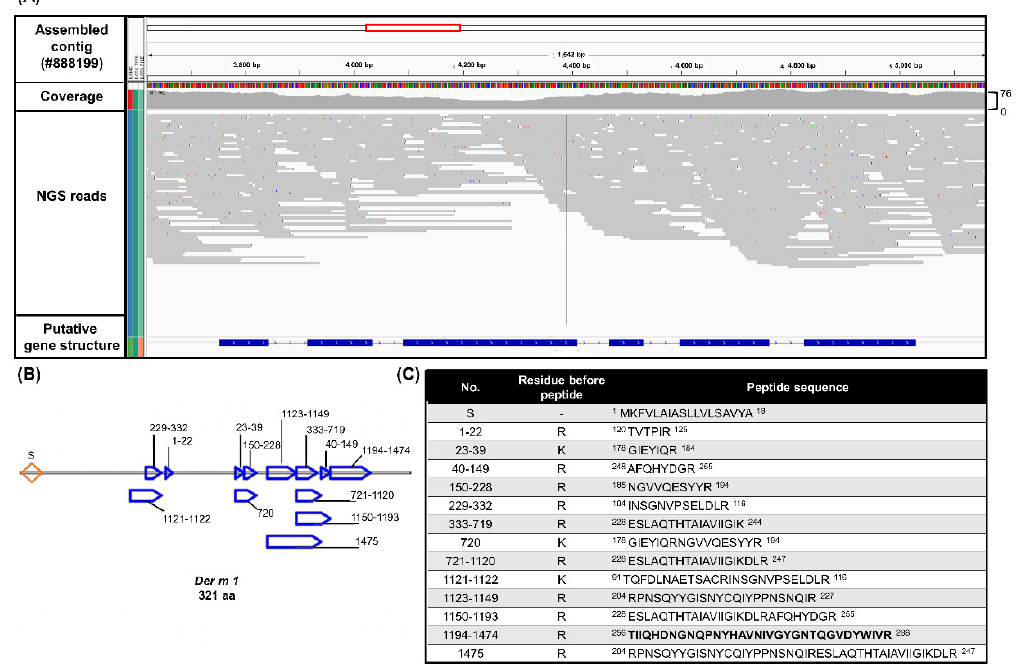
Figure 1. The annotated sequence of the major allergen Der m 1 . ( A ) The predicted DNA sequence of putative Der m 1 was shown by Interactive Genomics Viewer (IGV) with the aligned NGS reads as gray lines. The first and second rows show the assembled contig sequence (config #888199; 13,888 bp) and the NGS reads coverage, respectively. The third row shows the sorted NGS reads mapped to the corresponding region mismatching the assembled Der m genomic reference indicated by color with alpha transparency proportional to quality. The fourth row shows the predicted exon–intron structure of Der m 1 using the sim4 package. ( B ) The LC-MS/MS proteomic data showed the specific fragment of the deduced 231-amino-acid sequence of Der m 1 . The peptide fragments were mapped to the Der m 1 proteins and the unique peptide sequence of Der m 1 was shown. For the refused genes track of Der m 1 gene, the strain is oriented by an arrow while the bar and line indicated the exon and intron region, respectively. ( C ) LC-MS/MS theoretical Mass Spectra approach analysis of Der m 1 .